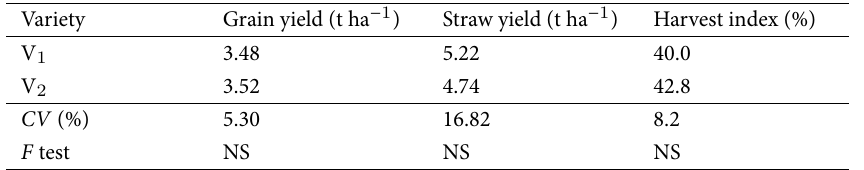
Table 5 Grain and straw yields of wheat influenced by the wheat varieties. Variety